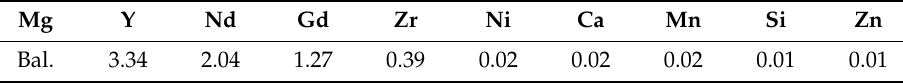
Table 1. Composites of as-cast base metal (wt. %).